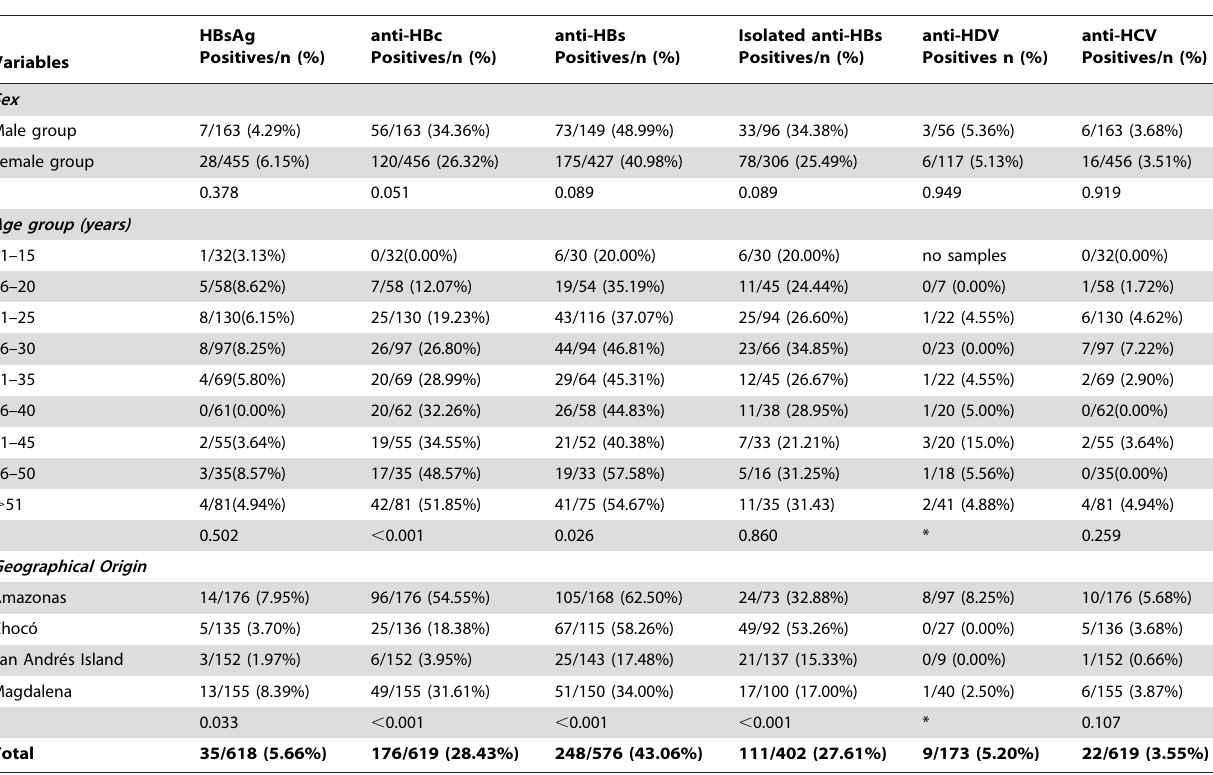
Table 1. Results for each HBV, HDV and HCV serology marker evaluated in the Colombian population ( . 11 years old).